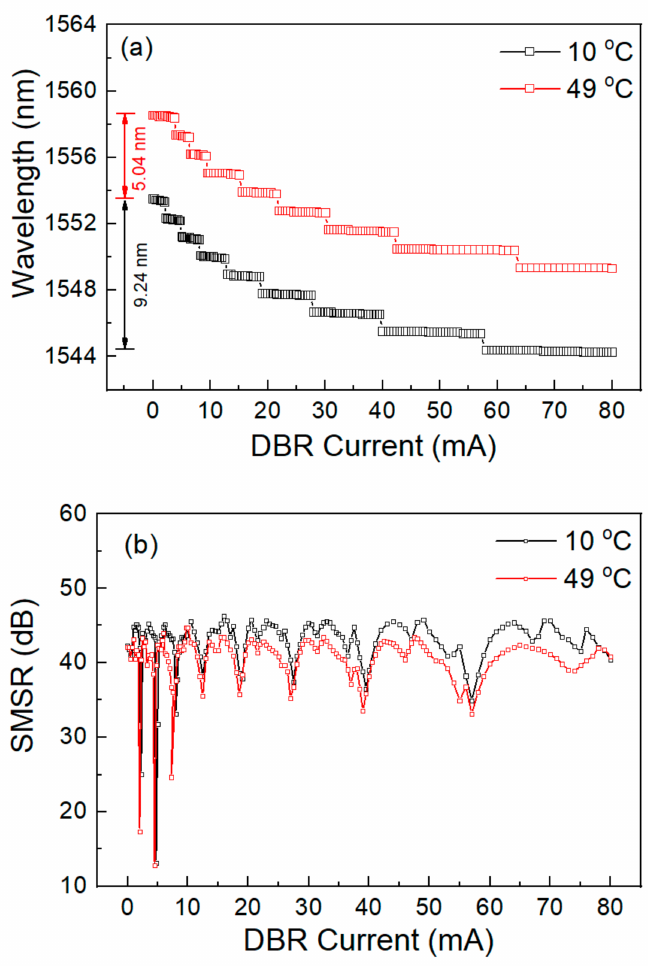
Figure 2. Laser emission wavelength ( a ) and sidemode suppression ratio (SMSR) ( b ) as functions of the injection current of the DBR section at a gain current of 80 mA at 10 and 49 ◦ C, respectively. In order to obtain a tuning range greater than 14 nm, the entire tuning wavelength at 10 ◦ C and the partial tuning wavelength at 49 ◦ C were selected to test the transmission performance of the tunable DBR laser. The typical optical spectra of the InGaAlAs DBR laser are shown in Figure 3, which are selected from the entire wavelength tuning range of 9.24 nm at 10 ◦ C and 5.04 nm at 49 ◦ C marked in Figure 2a, with SMSRs over 40 dB. The three wavelengths of 1544.34, 1551.18, and 1558.56 nm marked in Figure 3 are used to test the modulation and transmission